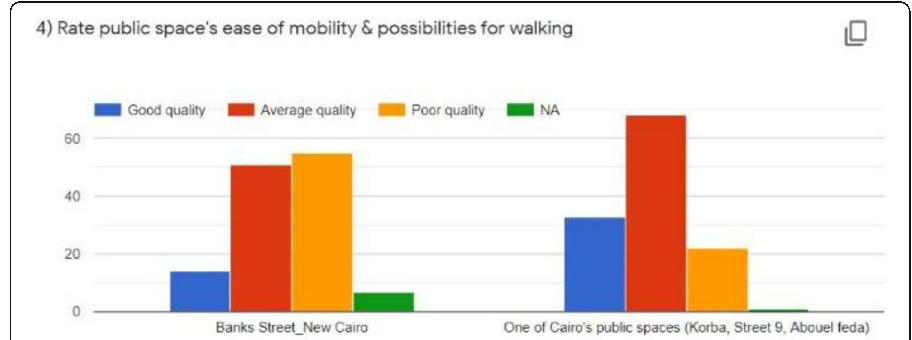
Fig. 18 Walkability experience in public spaces